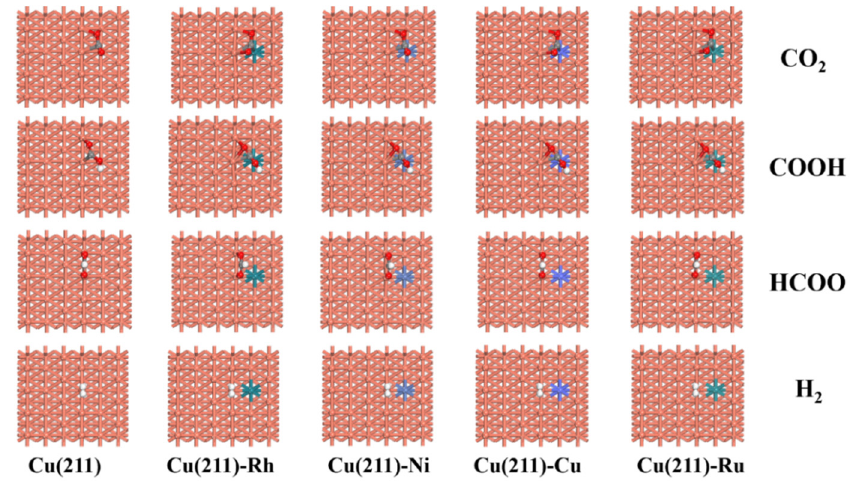
Figure 1. The stable adsorption configurations of CO 2 , COOH, HCOO, and H 2 on the pure and transition-metal-doped Cu(211) (M = Rh, Ni, Co, and Ru) surfaces.